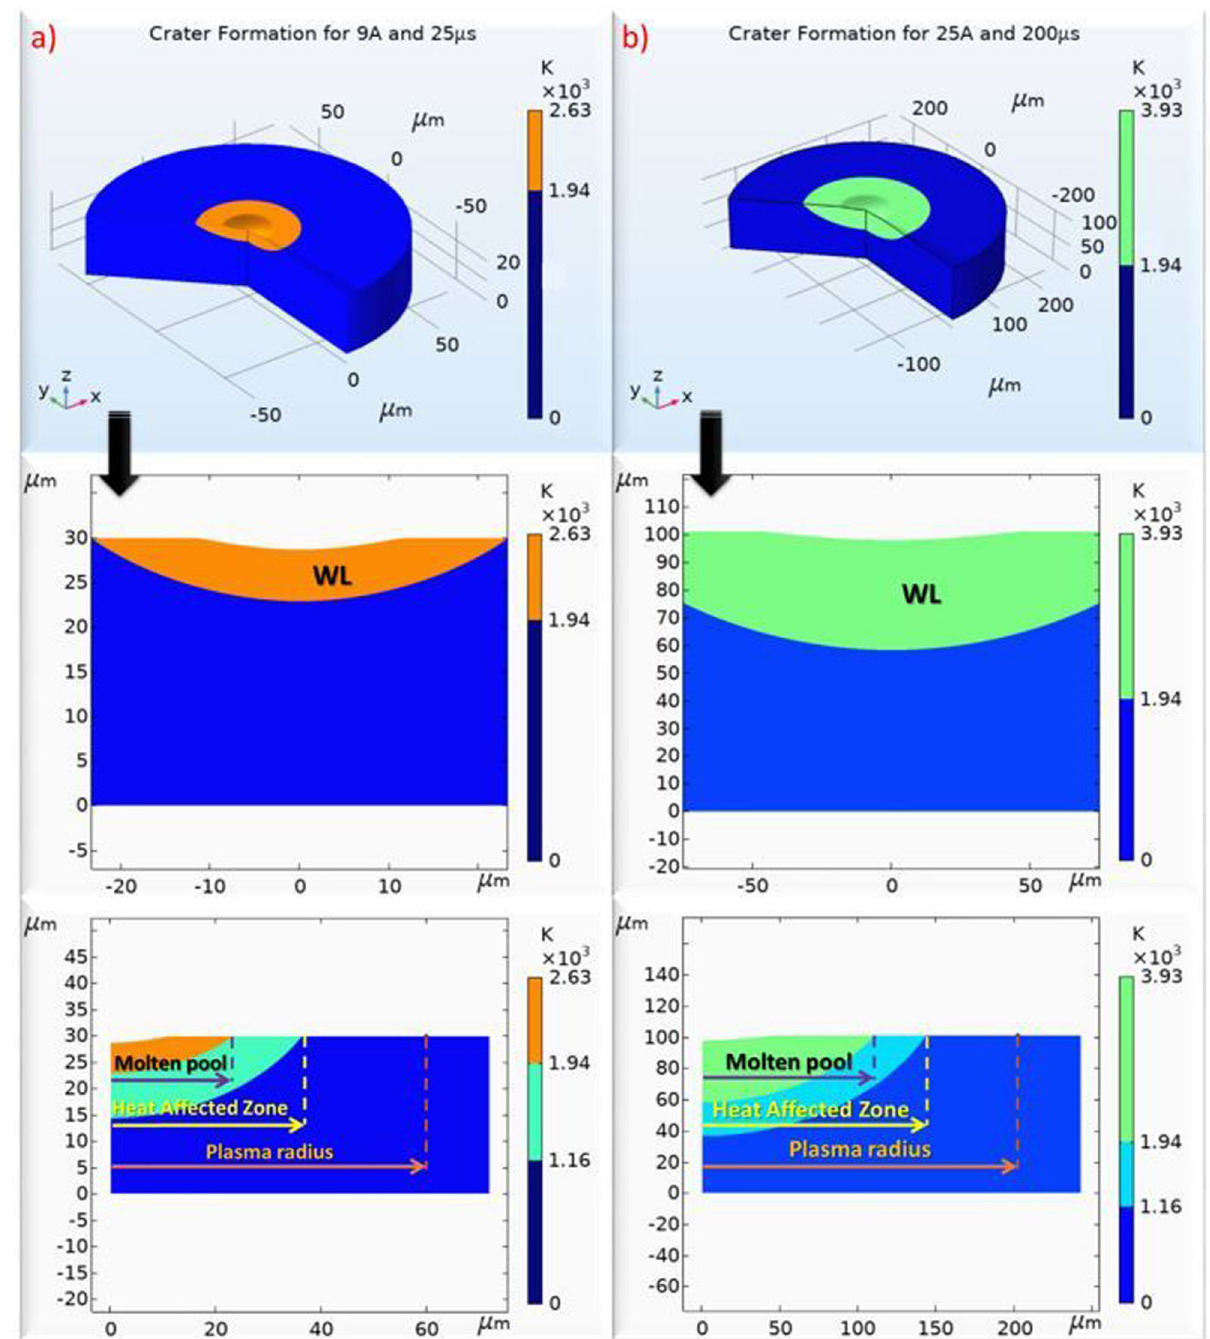
Figure 12. Simulated results for ( a ) 9A and 25 μs, ( b ) 25A and 200 μs where the formatted craters, as well as the WL and Heat Affected areas are